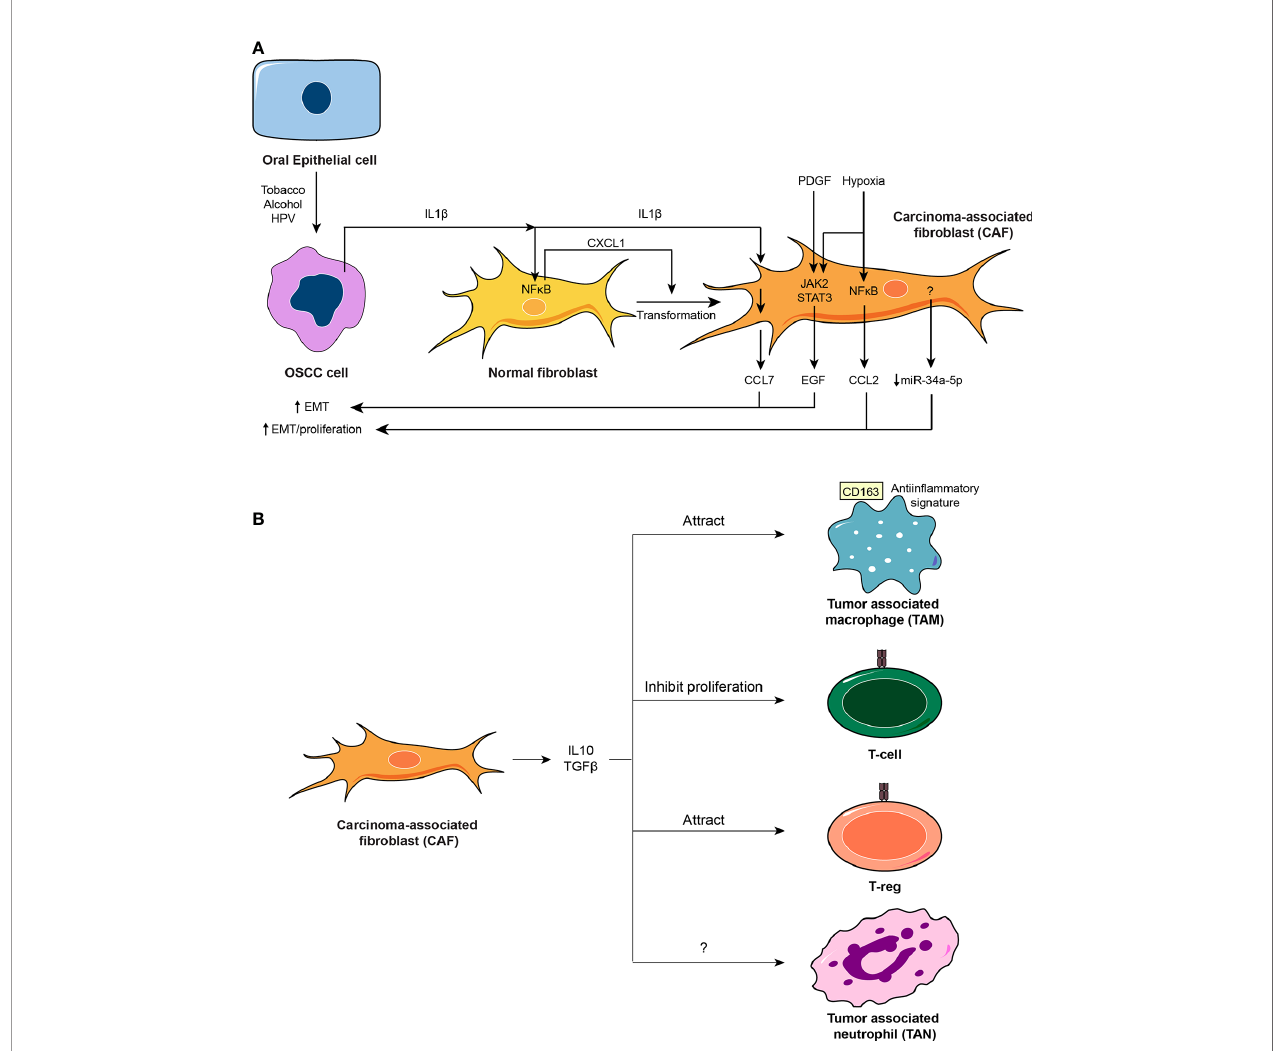
FIGURE 2 | The oral squamous cell carcinoma (OSCC) tumor microenvironment. (A) The OSCC tumor microenvironment is mainly composed of cancer-associated fi broblasts (CAFs). CAFs derive from normal fi broblasts after autocrine stimulation of chemokine (C-X-C motif) ligand (CXCL1) chemokine through a nuclear factor k B (NF k B)-dependent mechanism. NF k B is activated in fi broblasts by the action of interleukin-1 b (IL1 b ) released from OSCC cells. Conditions surrounding the tumoral tissue, such as increased levels of platelet-derived growth factor (PDGF) and IL1 b or hypoxia activate Janus kinase (JAK)/STAT and NF k B pathways in CAFs, which induce the release of chemokines (CCL2 and CCL7) and epithelial growth factor (EGF), or inhibit the release of selective miRs such as miR-34a-5p. All these mediators augment proliferation and EMT of OSCC cells. (B) CAFs release well known anti-in fl ammatory molecules such as IL10 and TGF b that attract anti- in fl ammatory macrophages and regulatory T-cells, T-regs, and inhibit proliferation of